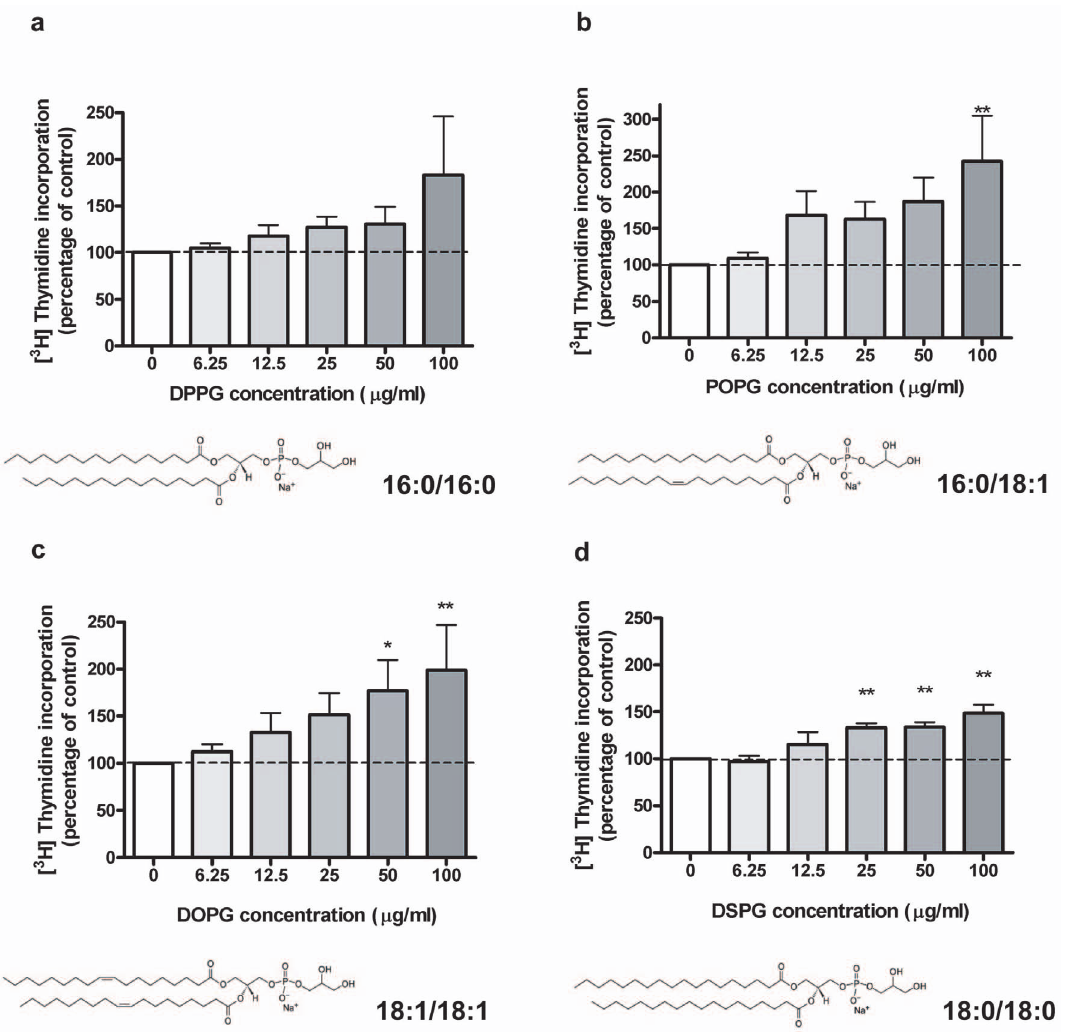
Figure 1. Effects of PG species containing saturated or monounsaturated fatty acids on keratinocyte proliferation. Near-confluent keratinocytes were treated for 24 hrs with the indicated concentrations of liposomes of DPPG (A), POPG (B), DOPG (C) or DSPG (D), prepared via bath sonication of the different PG species in SFKM. [ 3 H]Thymidine incorporation into DNA was then determined as in [10]. Values represent the means 6 SEM of 4 to 11 separate experiments performed in duplicate; *p , 0.05, **p , 0.01 versus the control value (0 m g/mL). [ 3 H]Thymidine incorporation into DNA in the control was 31,300 6 8,400 cpm/well, 33,600 6 9,800 cpm/well, 32,200 6 8,700 cpm/well, and 44,200 6 1,200 cpm/well for panels A, B, C and D,